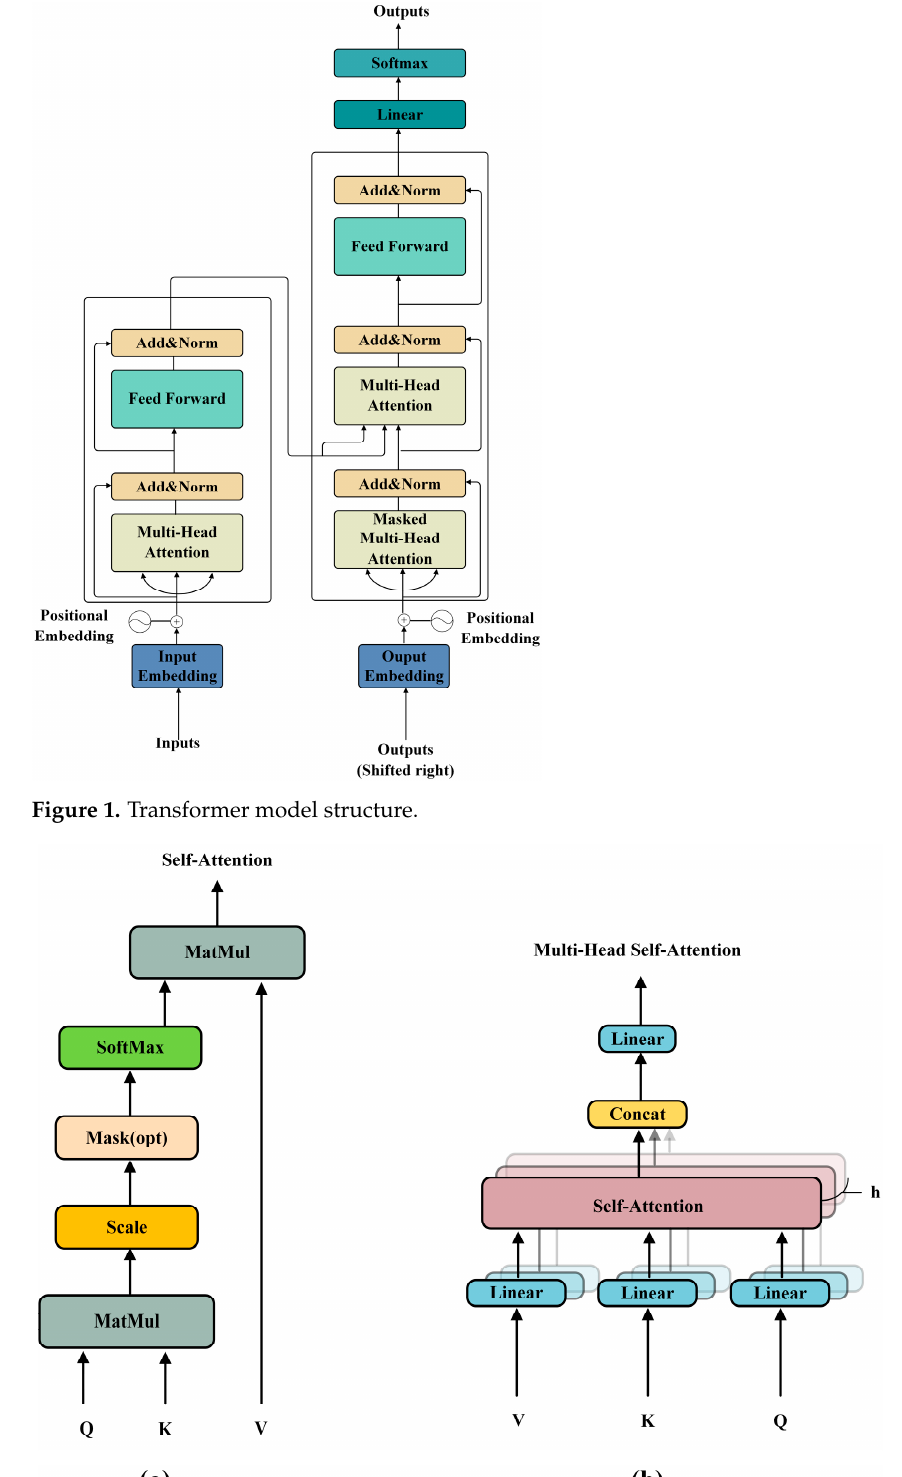
Figure 2. ( a ) Self-attention structure, ( b ) multihead attention structure.